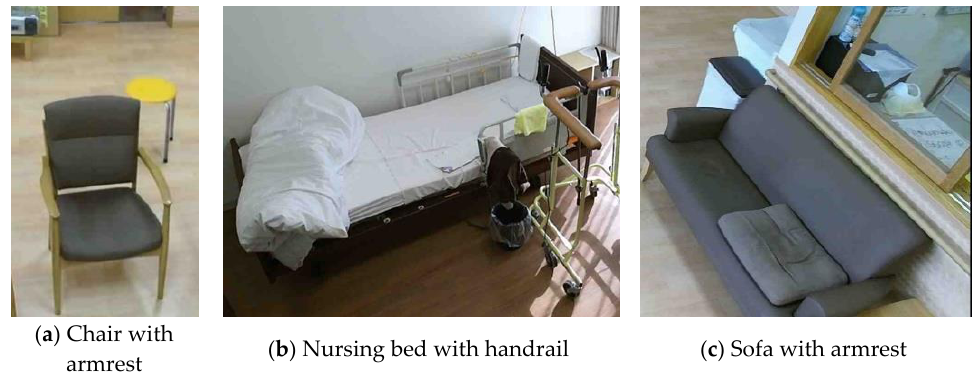
Figure 2. The products analyzed for standing behavior. Table 1. Motion ID and life ability score and product.